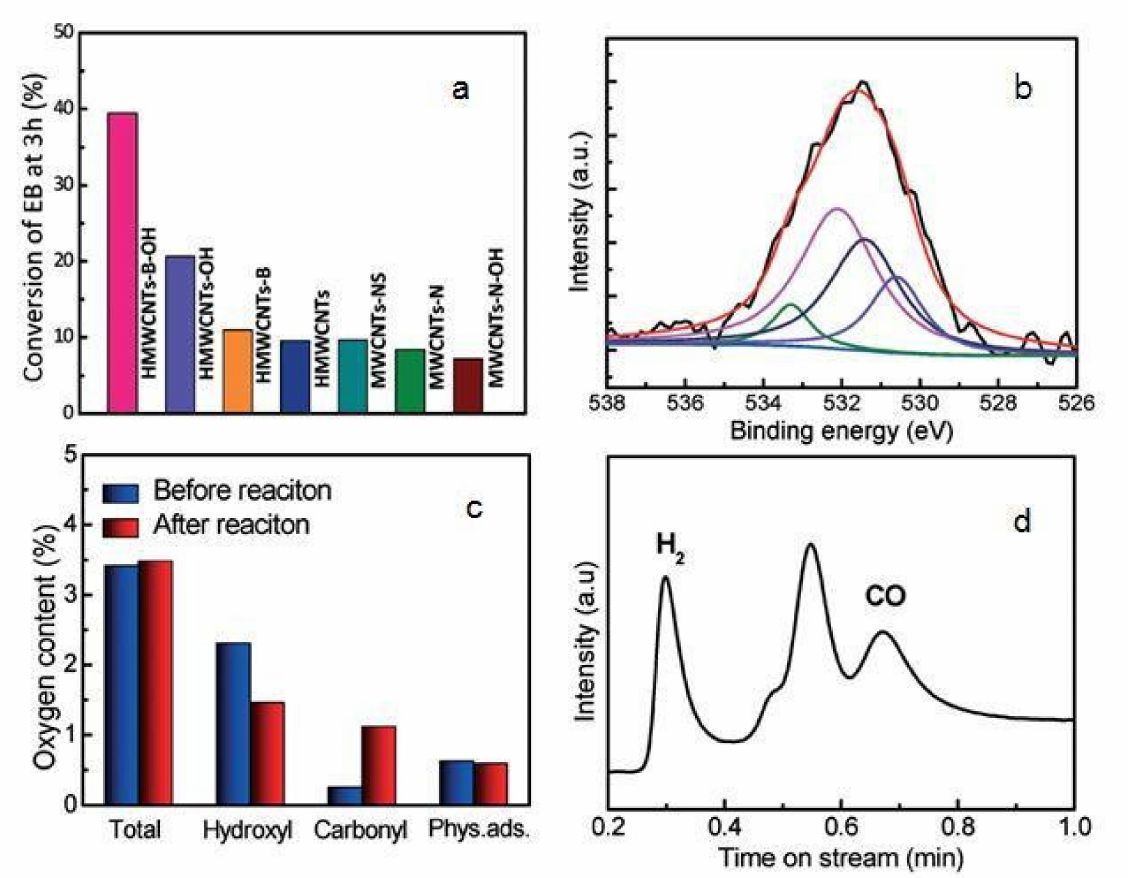
Figure 3. ( a ) Conversion of EB using CO 2 as a soft oxidant; ( b ) O1s spectra of HMWCNTs-B-OH after oxidative dehydrogenation by XPS for 3 hr; ( c ) Oxygen substance (mol%) of HMWCNTs-B-OH earlier and later oxidative dehydrogenation reaction at 3 h; ( d ) Gas derivatives of HMWCNTs-B-OH after oxidative dehydrogenation at 3 h. (Reprinted from [44]; copyright (2013), Royal Society of